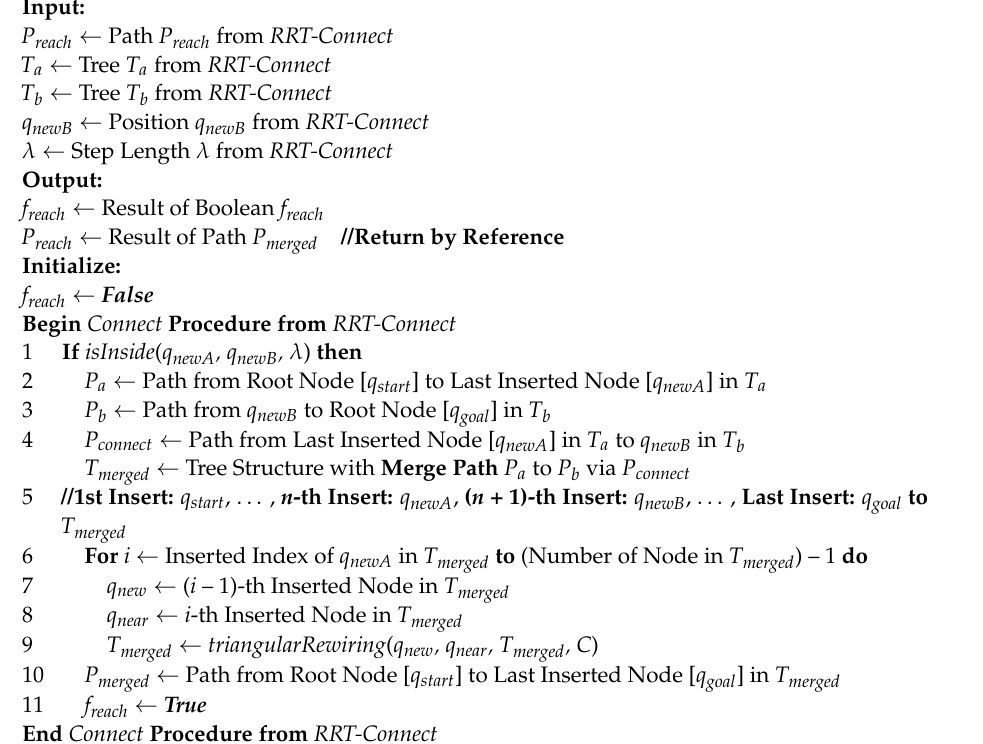
Algorithm 6 Pseudocode of the Proposed ‘Connect’ Method for the RRT-Connect Algorithm